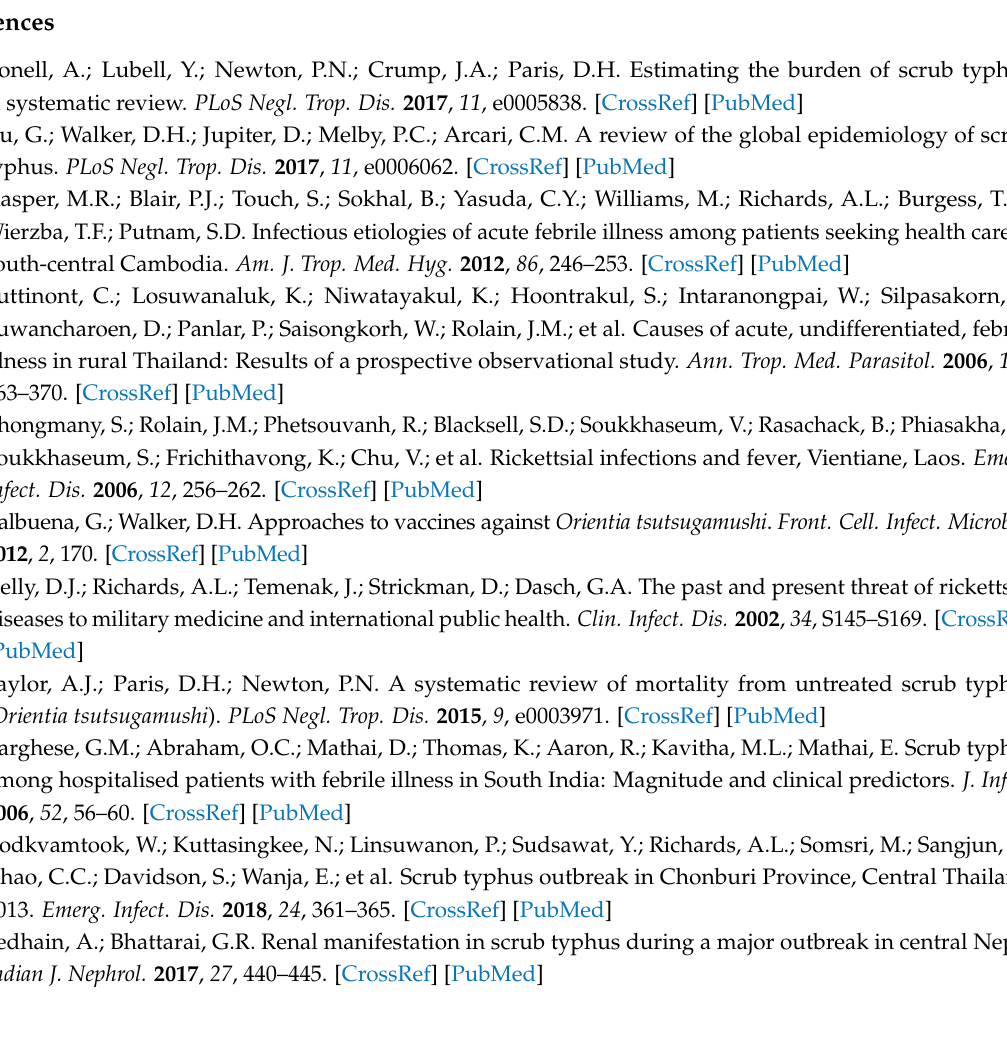
Table S1: Nucleotide and amino acid identity values for O. tsutsugamushi OmpA